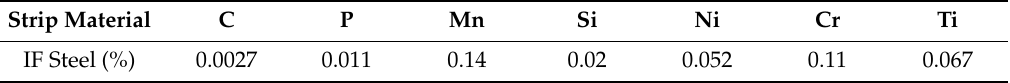
Table 1. Chemical composition of disc (interstitial-free (IF) steel) (wt. %).